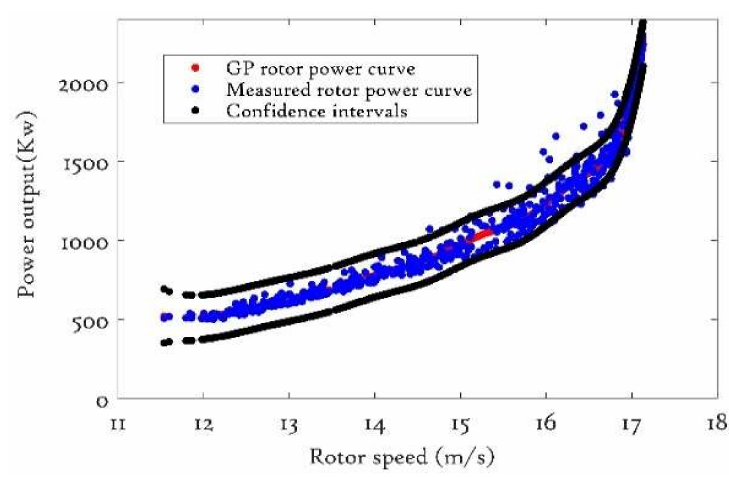
Figure 11. GP rotor speed curve with CIs.